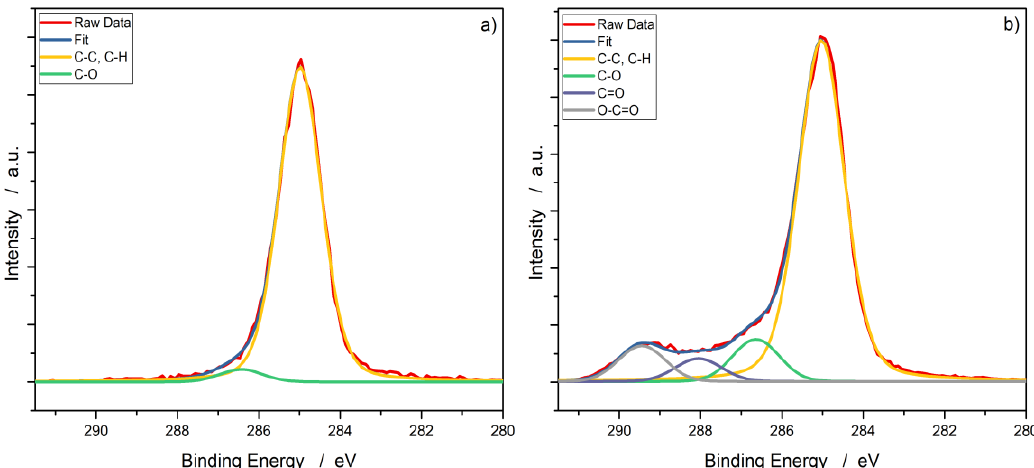
Figure 3. XPS data of the carbon peak with fitted Voigt profiles of PP60 ( a ) before and ( b ) after plasma treatment with Ar/N 2 as the working gas.